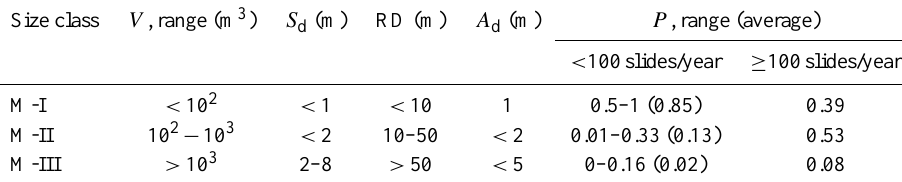
Table 1. Magnitude class for landslides on cut